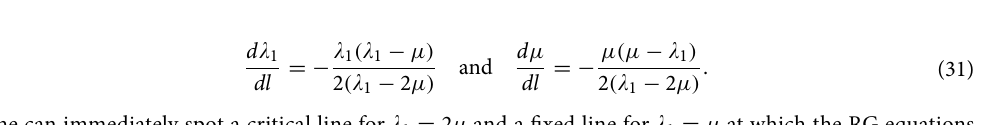
µ (dashed line) which are critical and fixed lines =